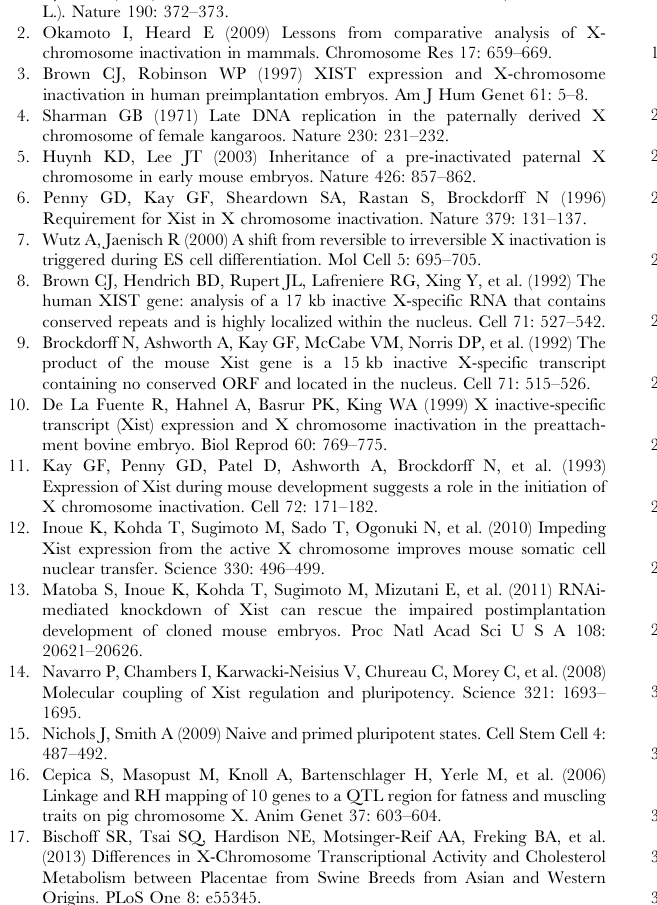
Figure S4 Identification of transcription start sites and the termination site of porcine XIST . (A) Transcription start sites (TSSs) of the porcine XIST gene were identified by 5 9 RACE- PCR. Eight putative TSSs were confirmed (red color characters),